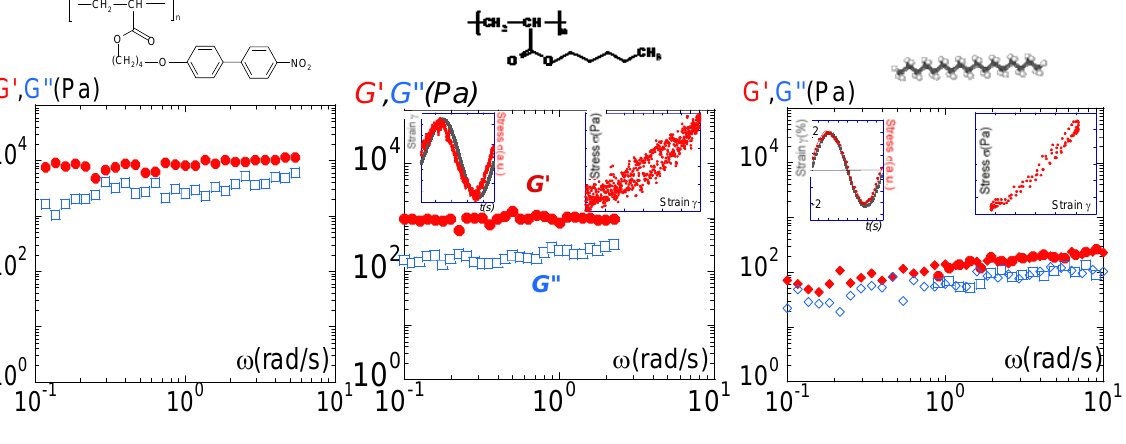
Figure 6. ( a ) Frequency dependence of the elastic (G ′ : ● ) and the viscous (G ″ : □ ) moduli of PANO2 at 3 °C above the NI transition, 0.050 mm gap thickness and 0.3% strain amplitude; ( b ) Frequency dependence of the elastic (G ′ : ● ) and the viscous (G ″ : □ ) moduli of PBuA at room temperature (Tg = − 63°C), 0.020 mm gap thickness and 0.5% strain amplitude (from reference [29]). Two insets have been added to illustrate the quasi-superposition of the strain input wave ( ■ ) and of the torque output wave ( ● ), and the corresponding Lissajous cycle respectively; ( c ) Frequency dependence of the elastic (G ′ : ● : 0.5% strain, ♦ : 1% strain) and the viscous (G ″ : □ : 0.5% strain, ◊ : 1% strain) moduli of the heptadecane at 3 °C above the crystallization (Tf = 21 °C) temperature and 0.058 mm gap thickness. Two insets illustrate the quasi-superposition of the strain input wave ( ■ ) and of the torque output wave ( ● ) and to display the corresponding Lissajous